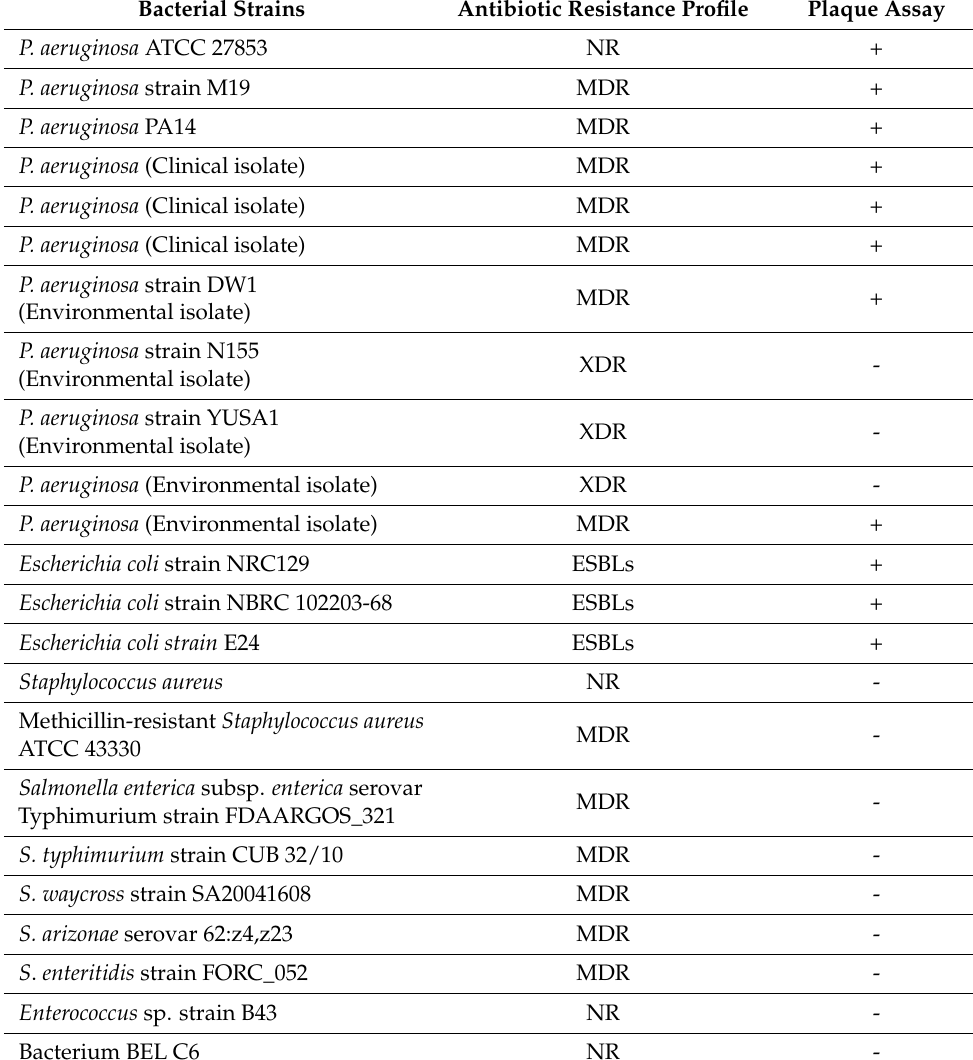
Table 1. Host range of vB_PseuP-SA22 against P. aeruginosa and other bacterial species. Bacterial